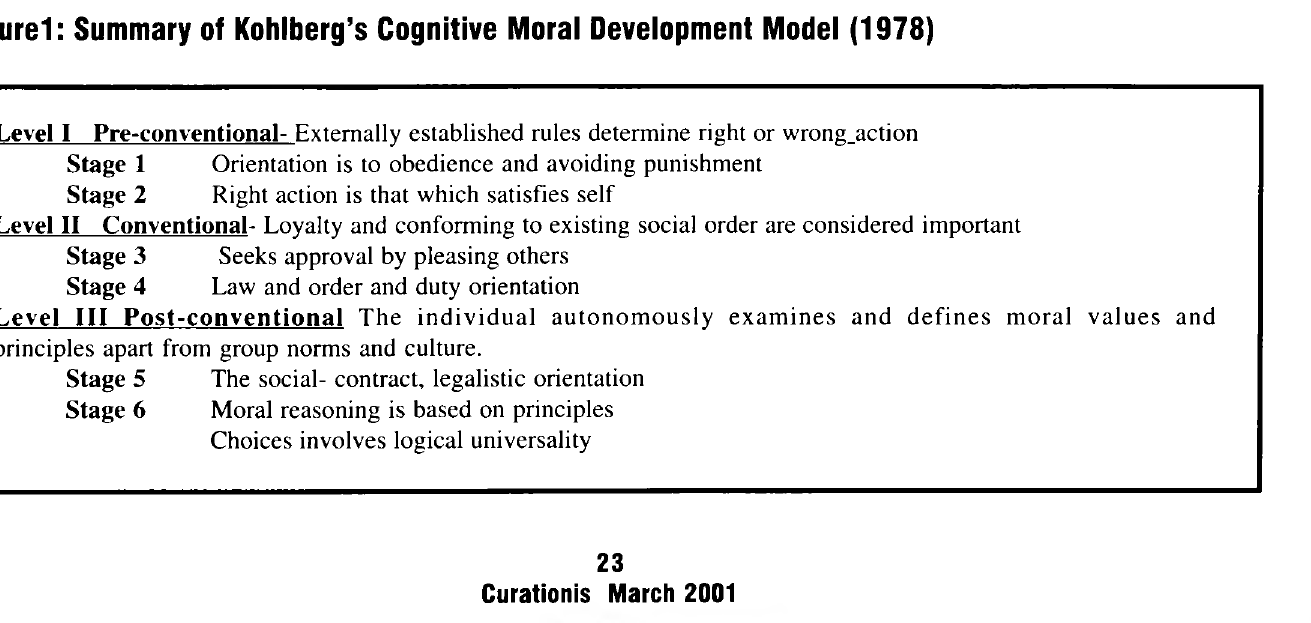
Level I Pre-conventional- Externally established rules determine right or